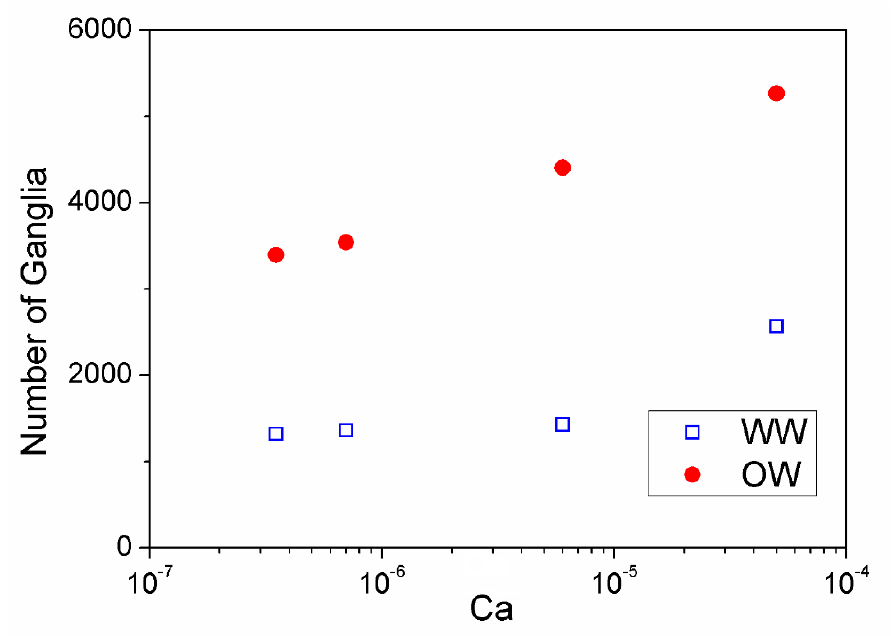
Figure 11. Number of trapped oil ganglia as a function of capillary number for water-wet and oil-wet devices.